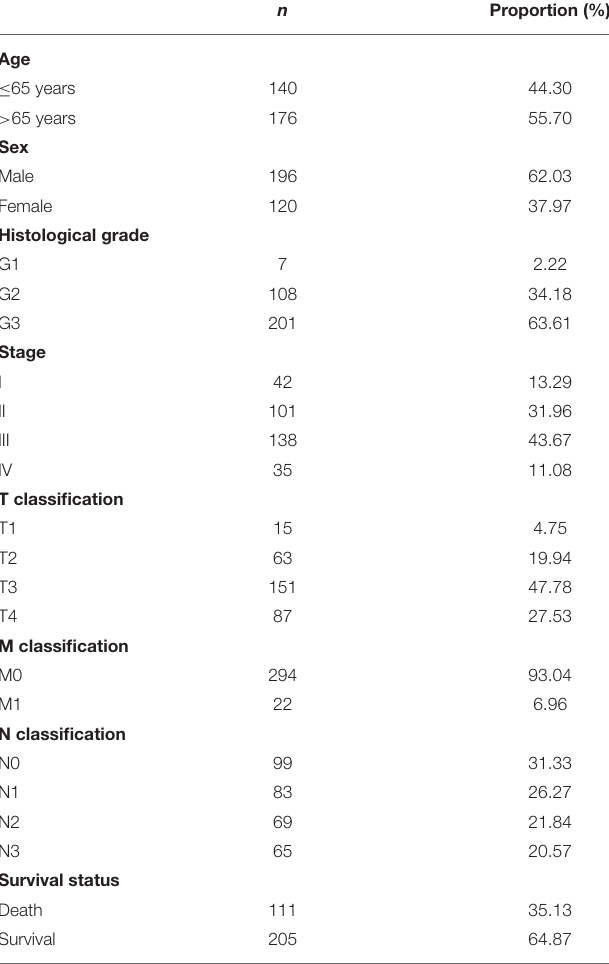
TABLE 1 | Clinical characteristics of patients with gastric